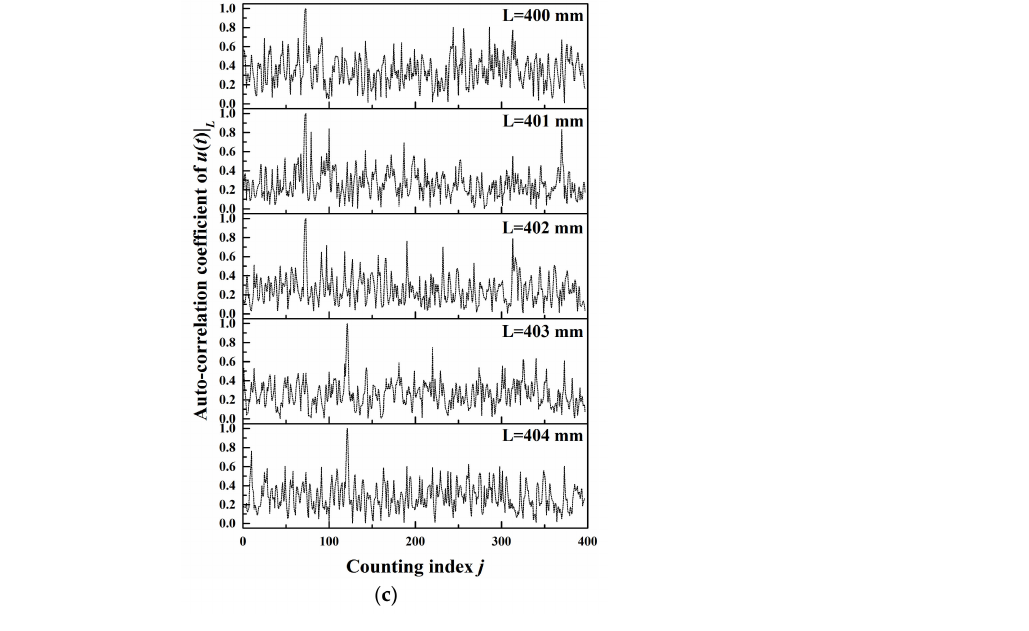
( L = 401 mm,402 mm, L , ( b )—Bounds results of L . L